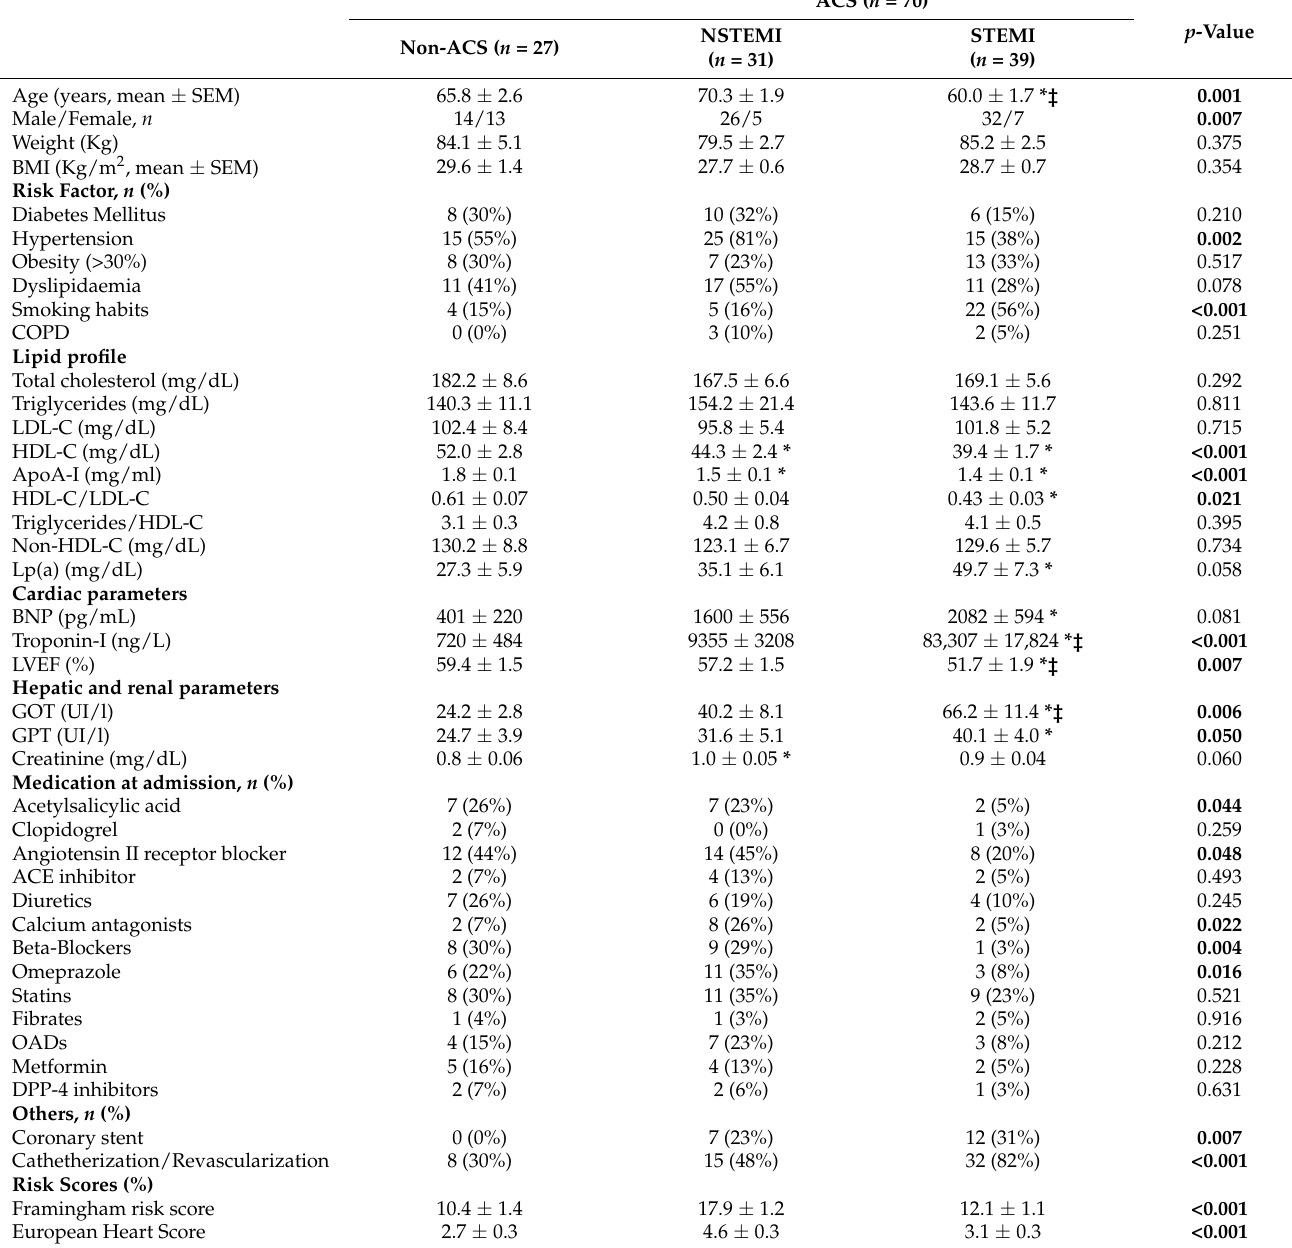
Table 1. Patient characteristics: Electrocardiogram classification. The chi-squared test was applied for categorical variables and the ANOVA test for numerical variables. The Bonferroni post hoc test was run for two group comparisons after ANOVA: * , Significant differences versus non-ACS; ‡ , Significant differences between STEMI and NSTEMI. Values of p < 0.05 are considered significant. Abbreviations: ACS = acute coronary syndrome, ApoA-I = Apolipoprotein A-I, NSTEMI = non-ST-segment-elevation myocardial infarction, STEMI = ST-segment-elevation myocardial infarction, BMI = body mass index, COPD = chronic obstructive pulmonary disease, BNP = B-type natriuretic peptide, LVEF = left ventricular ejection fraction. GOT = glutamic-oxaloacetic transaminase, GPT = glutamic-pyruvic transaminase, ACE inhibitor = angiotensin-converting enzyme inhibitor, OAD = oral anti-diabetic agents, DPP-4 inhibitors = dipeptidyl peptidase 4 inhibitors. ACS ( n = 70) NSTEMI ( n =